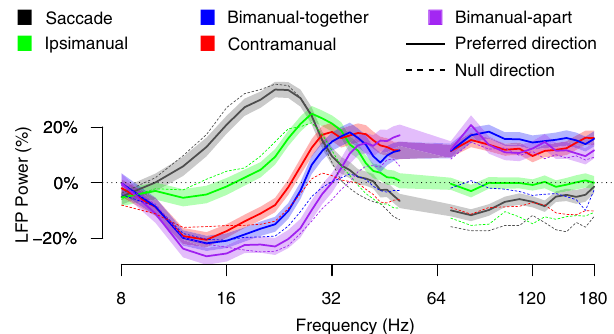
Fig. 4 LFP power as a function of movement type and frequency. LFP power is computed over the delay period for movements in the preferred and null directions. In the 16 – 32 Hz range power depends on task and frequency. In the 70 – 170 Hz range power depends on the task and is relatively stable across frequency. Data are for the 113 sites from which a tuned unit was simultaneously obtained. Source data are provided as a Source Data fi